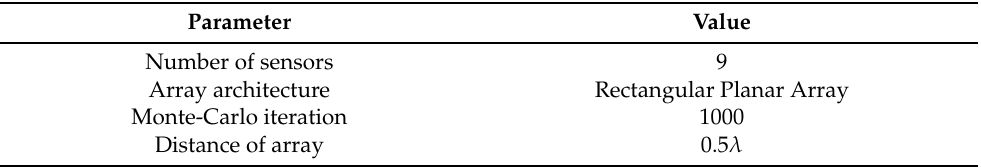
Table 2. Simulation condition for arbitrary array.